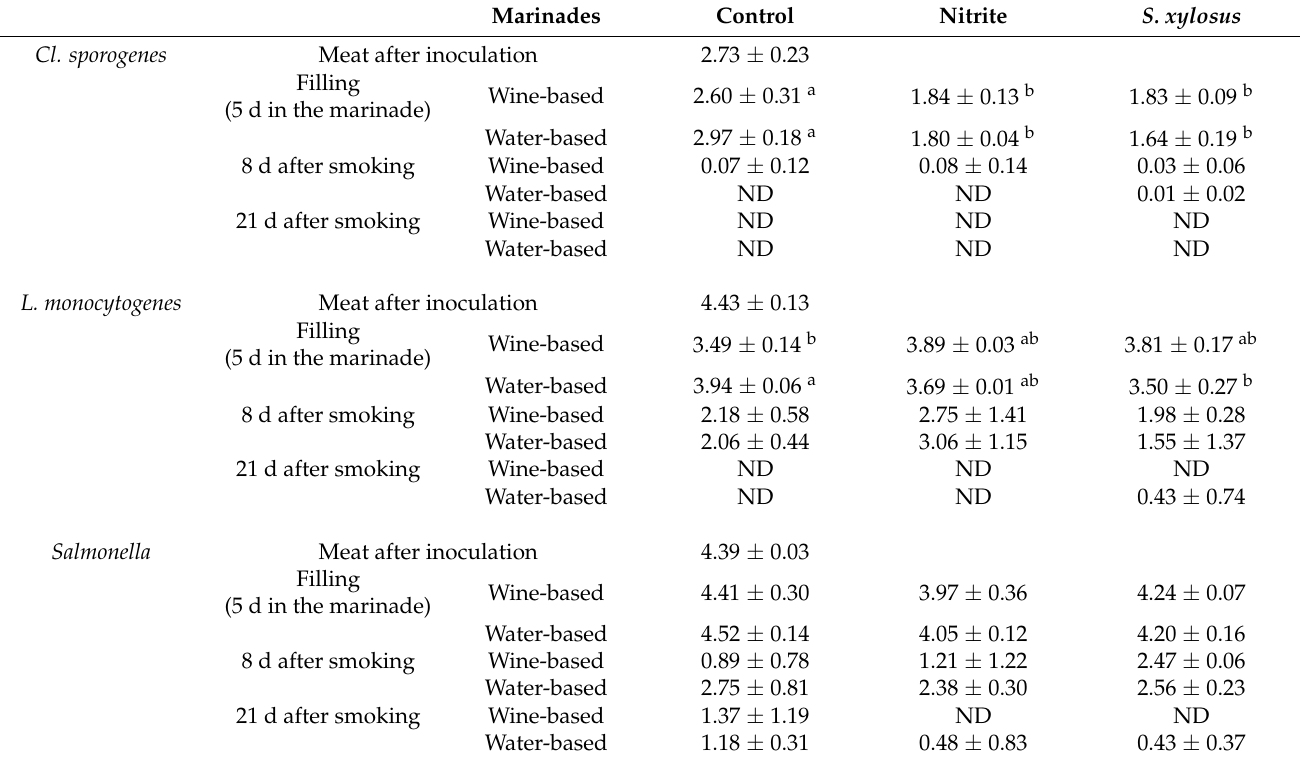
Table 7. Counts of Cl. Sporogenes, L. monocytogenes , and Salmonella in the challenge test made with cured loins. Results are presented as the mean and standard